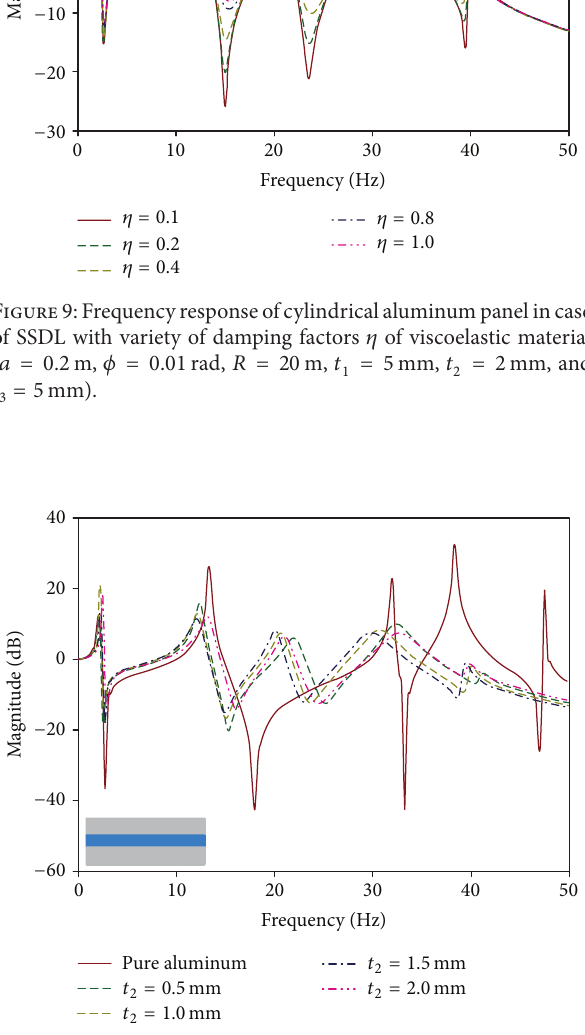
= 5 mm, 𝑡 = 5 mm, 1 3